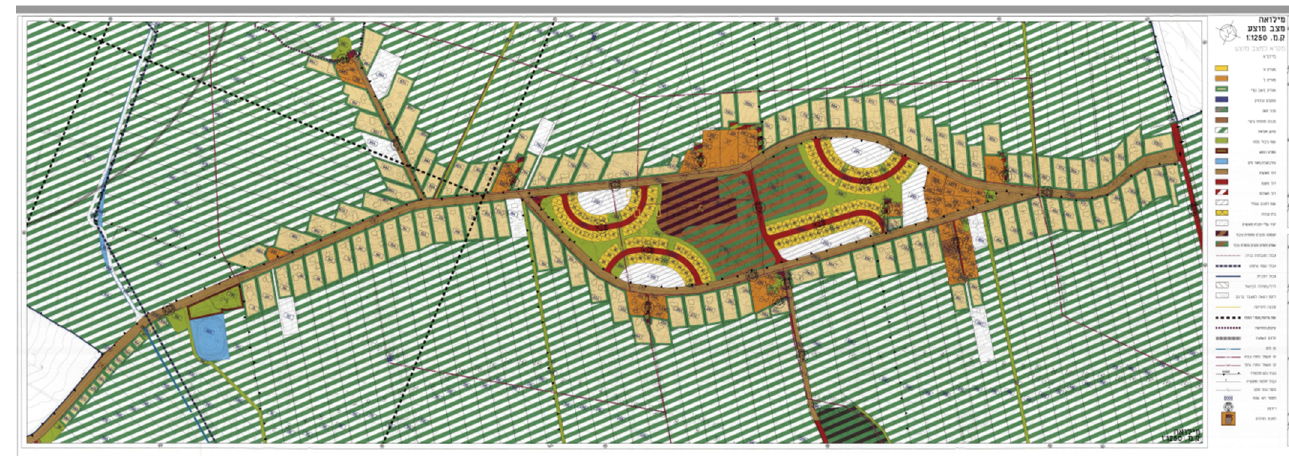
Figure 14. Housing extension plan at HaYogev: residential units at the expense of the vacant community center, in yellow; new roads, in red. Plan C/17676, Arch. Ruti Rohtin, 2014.